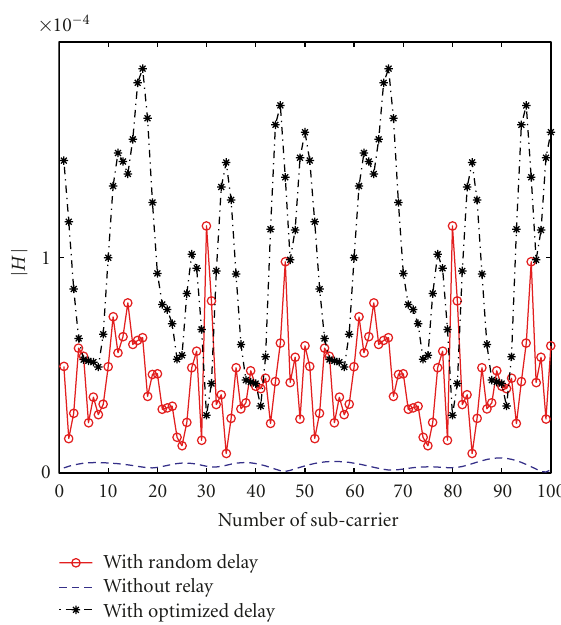
Figure 9: A snapshot of a frequency selective channel before and after adding cyclic delays for the case of three active